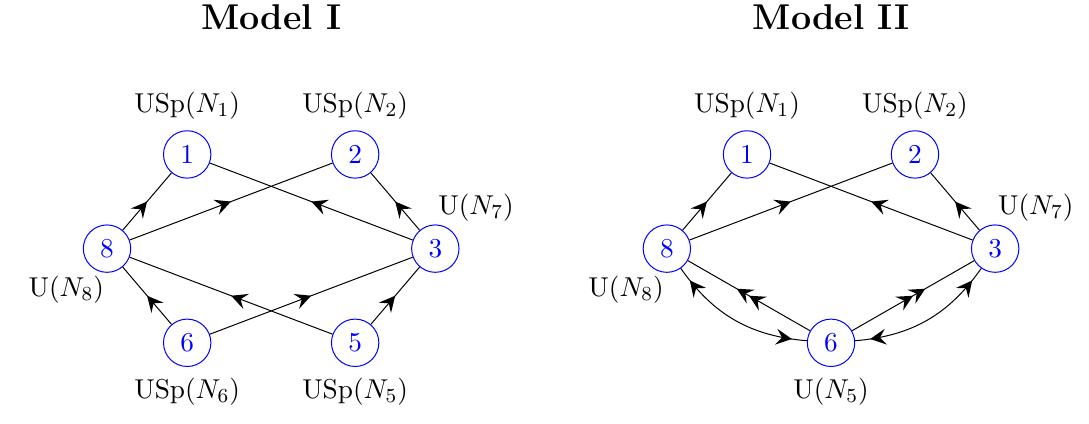
Figure 4 . Unoriented quiver diagrams for model I (left) and model II